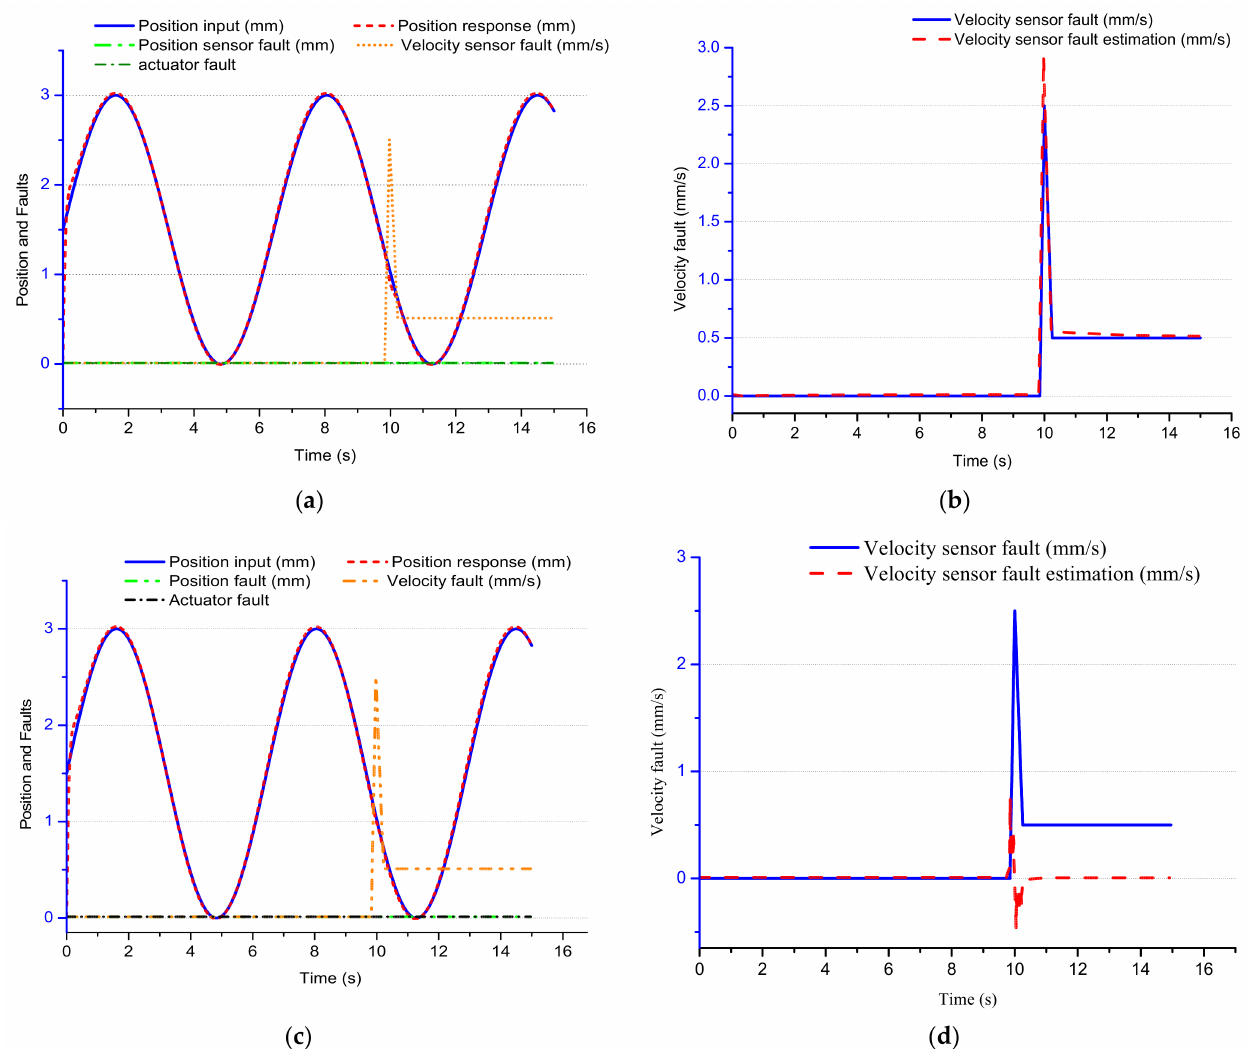
Figure 5. Simulation results of EHA system under the velocity sensor fault impact. ( a ) Position response for the case of only velocity sensor fault ( f p = 0; f a = 0 ) . ( b ) Velocity fault estimation for the case without velocity sensor fault compensation. ( c ) Position response for the case with velocity sensor fault compensation. ( d ) Velocity fault estimation for the case with velocity sensor fault